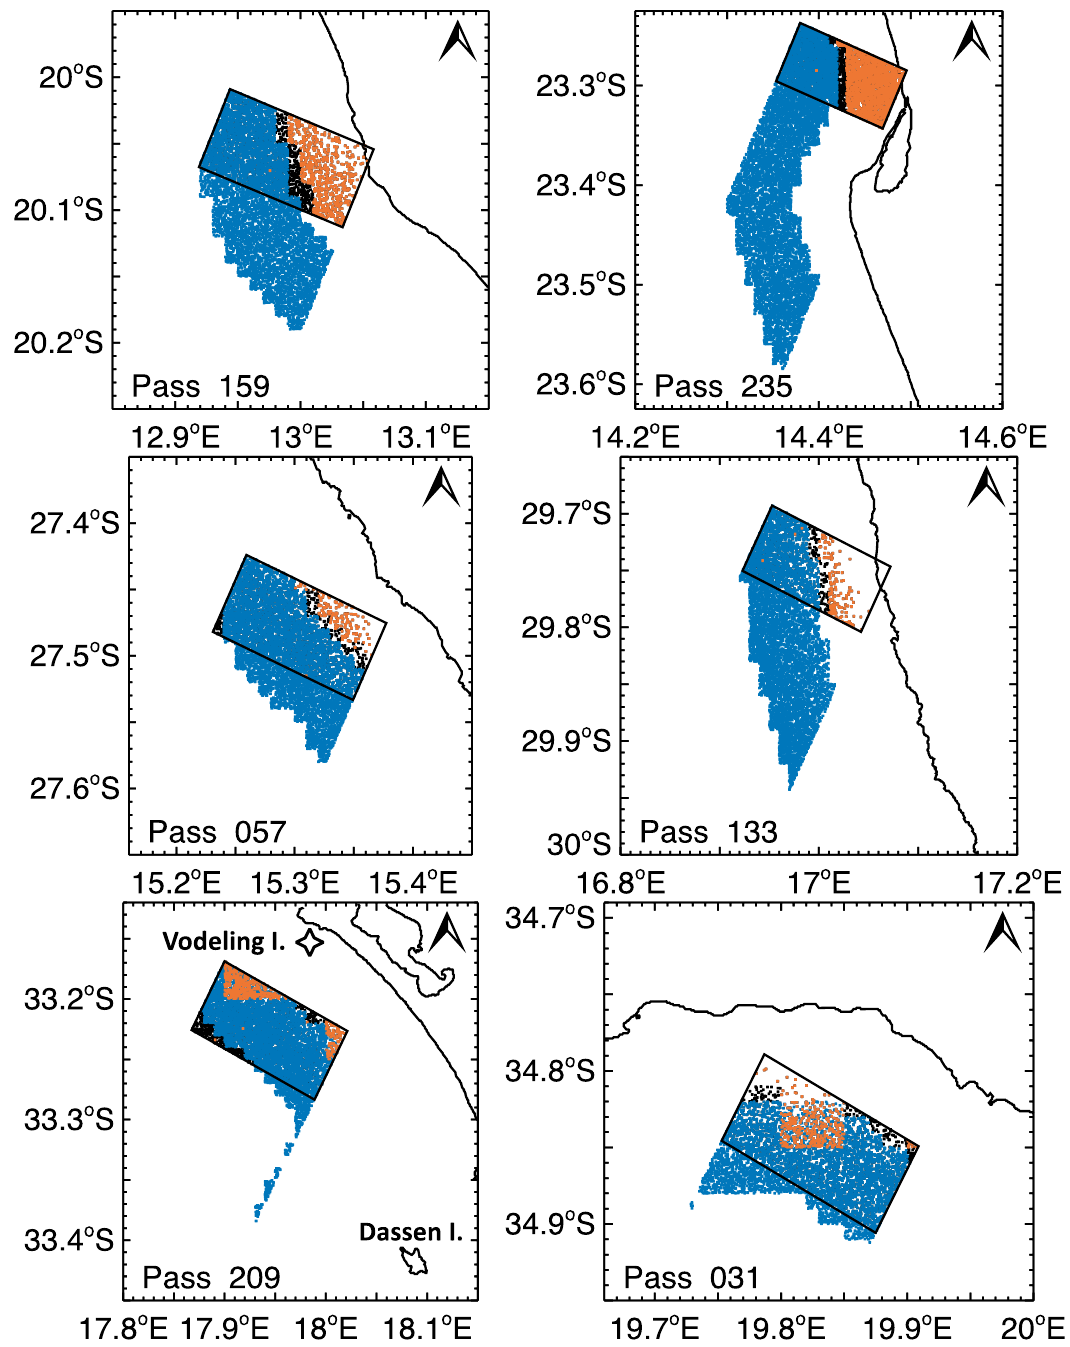
Figure 7. For each altimeter track, the closest 7 km × 13 km box used to average the scatterometer wind speeds in Figure 5 is shown. Shown also are all retrievals within 7–13 km of land and within 6.5 km of the altimeter track (blue). Within each box, retrievals flagged by the “Poor Coastal Processing” flag as ‘suspect’ are in orange. Retrievals closer than 7 km or farther from 13 km from land but not flagged are shown in